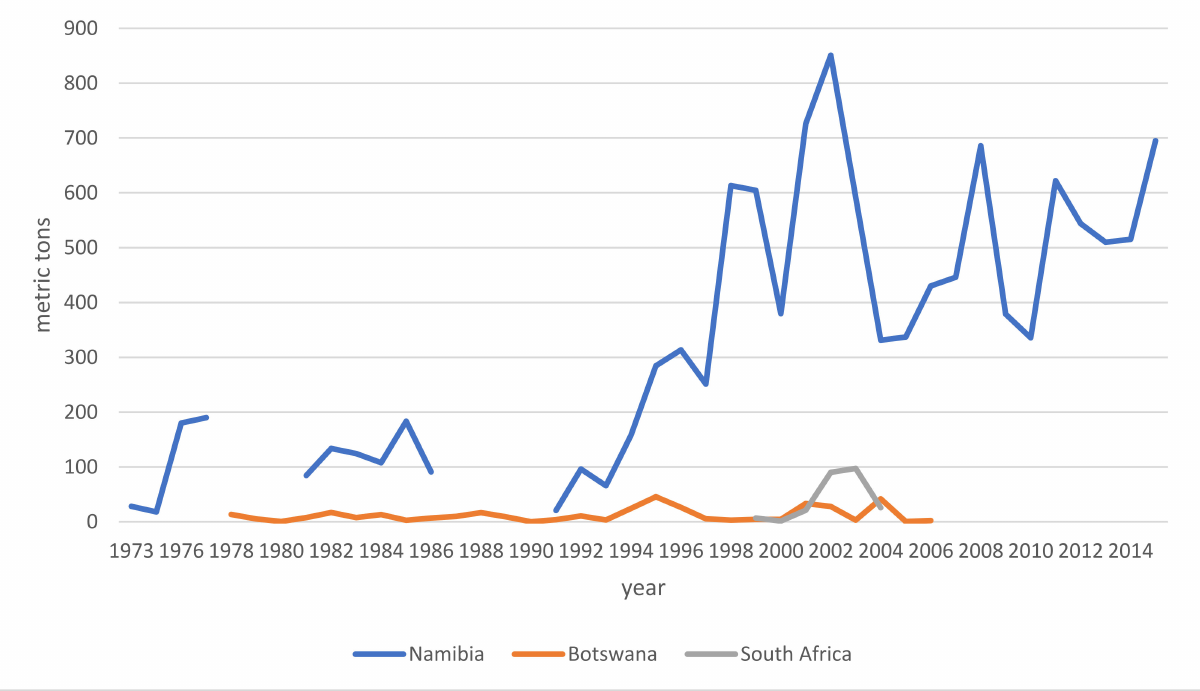
Figure 6. Devil’s claw exports by country—gaps reflect years in which no data was